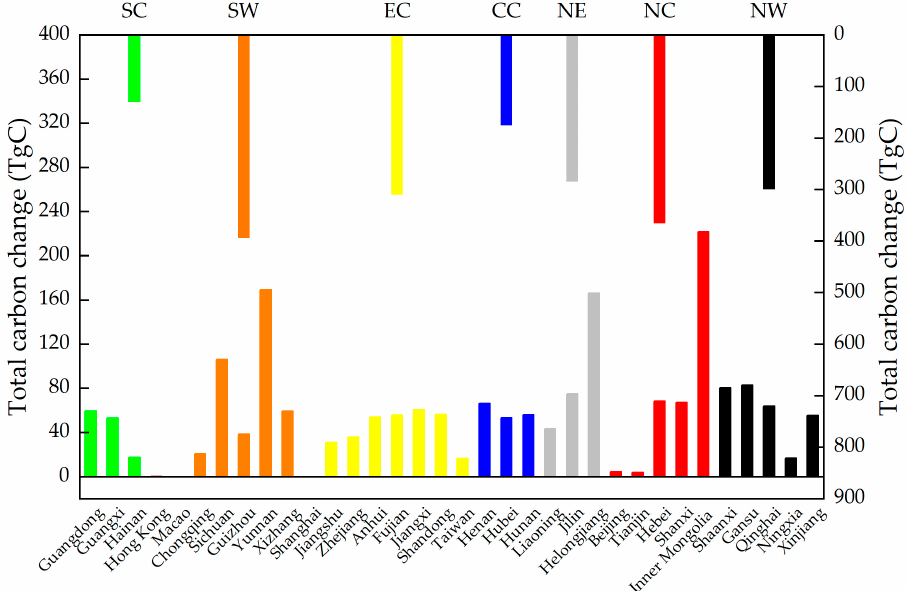
Figure 7. Provincial-level (the primary axis) and regional-level (the secondary axis) net changes in the total carbon sequestration from 2000 to 2018.